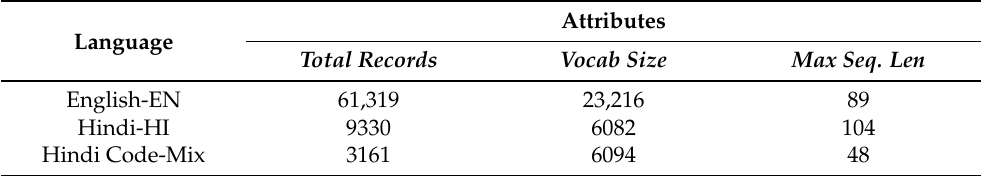
Table 1. Multilingual dataset